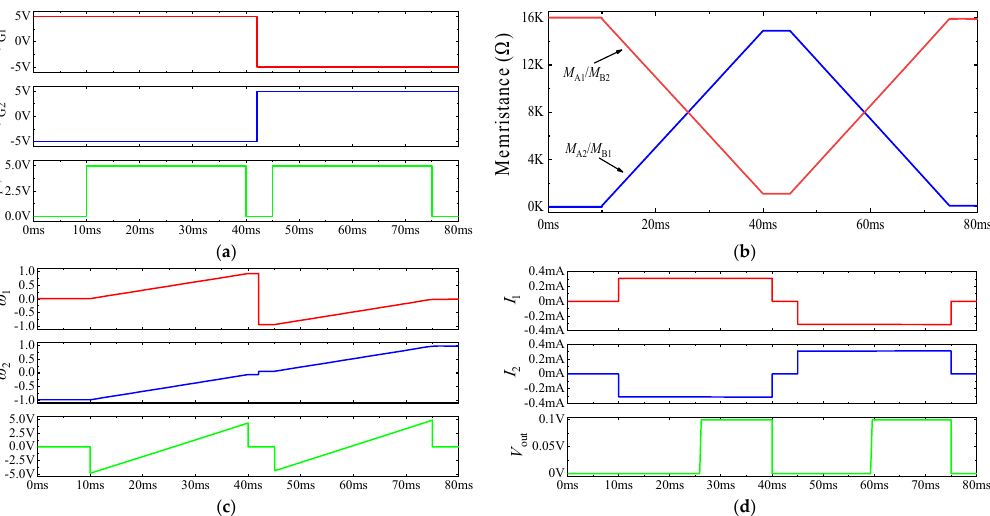
Figure 3. Simulation results of neuron circuit connecting two synaptic circuits: ( a ) control voltage and weight programming voltage; ( b ) resistance curve of the memristor in the synaptic circuit; ( c ) circuit weight and summation voltage V O ; ( d ) current flowing through memristor and output voltage V out . In the time period 0–10 ms, V p1,2 = V in1 = V in2 = 0 V, while the memristance and the weights ω 1 (0) ≈ 0 and ω 2 (0) ≈ − 1 remain unchanged. The first weight programming stage initiates at 10–40 ms, and the weight programming voltage V p1,2 = 5